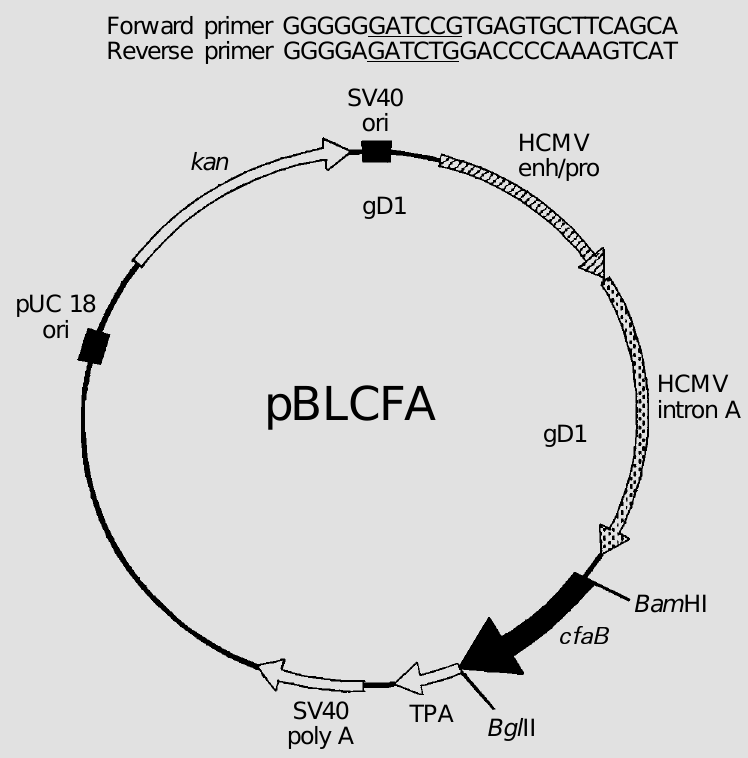
Figure 2 - Schematic representation of pBLCFA. Forward and reverse primers containing restriction sites (underlined sequences) for Bam HI and Bgl II, respectively, were used to amplify a synthetic gene encoding the mature CFA/I subunit ( cfaB ). The pKCMVintBL was digested with such enzymes, as also was the PCR-generated cfaB gene fragment. The cfaB gene was then cloned in the pKCMVintBL upstream of the tissue plasminogen activator (TPA) signal sequence, which served to target CFA/I to the extracellular space. HCMV, Human